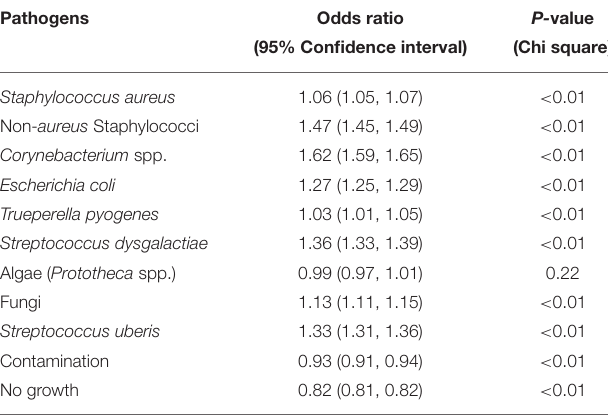
TABLE 2 | Result of univariable regression analysis of the proportion of samples positive for major mastitis pathogens by year. Pathogens Odds ratio P- value (95% Confidence interval) (Chi